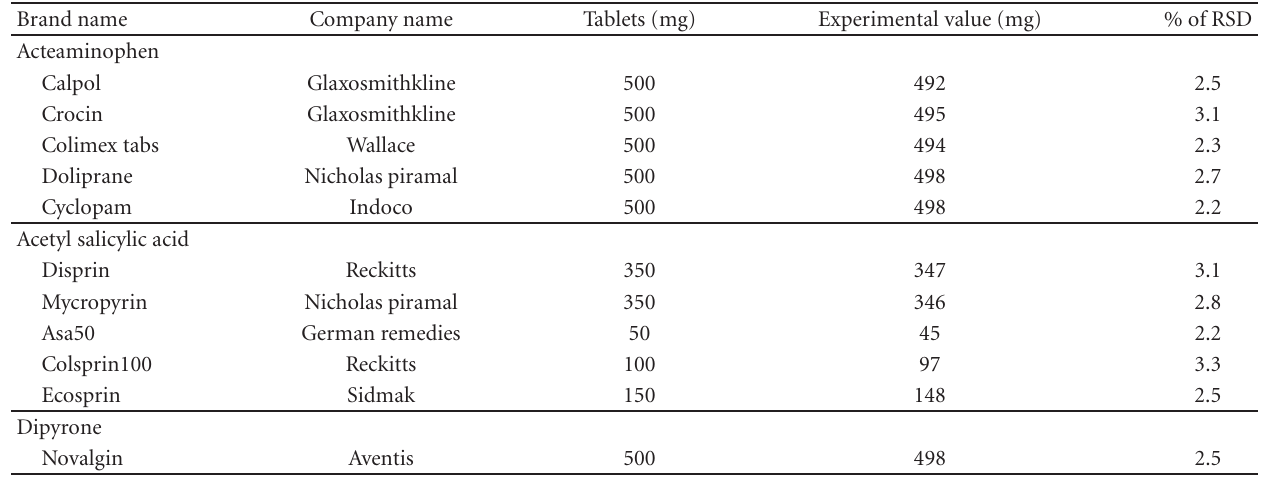
Table 5: Amount of drugs in tablets determined by SWSV in tablets.